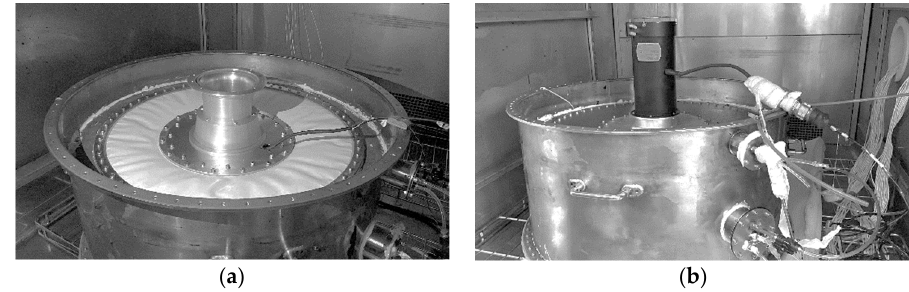
Figure 12. ( a ) MIX-130 fan test status; ( b ) MAX45016 fan test status.